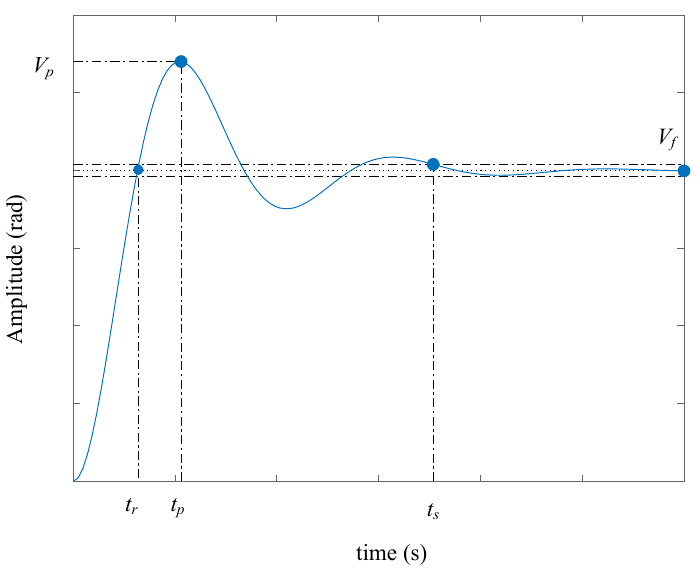
Figure 8. Closed loop response of motor shaft position with proportional